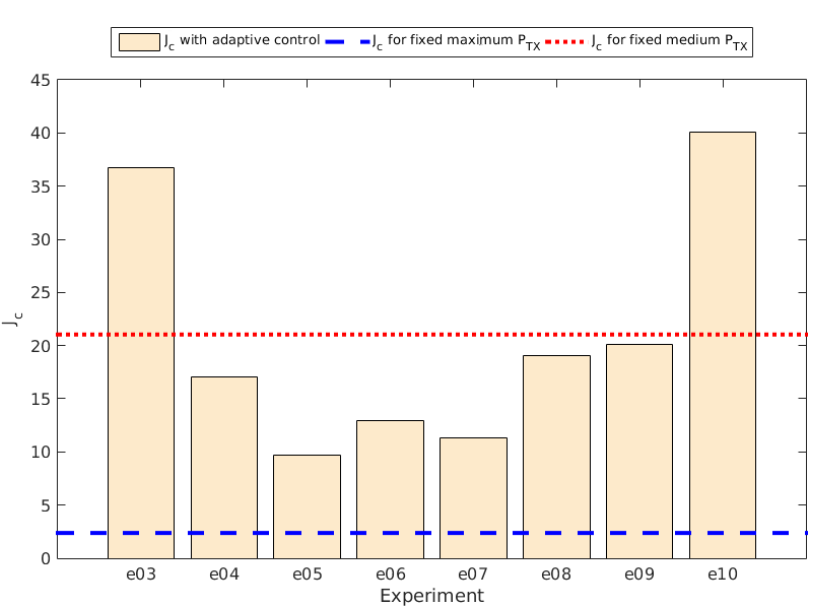
Figure 11. J for total transmission error rate per experiment comparison. c Table 4. Values of the evolution for the total error rate per